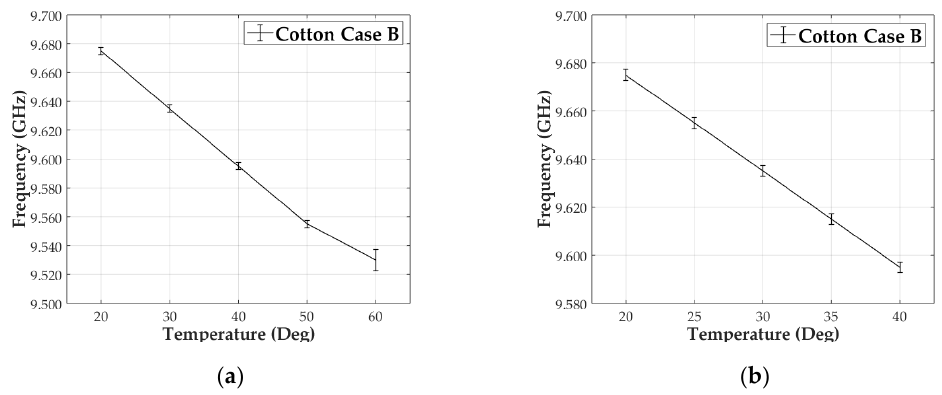
Figure 10. Measured frequency vs temperature representation. Cotton Case B at 9.45 GHz for: ( a ) 20– 60 °C/10 °C steps and ( b ) 20–40 °C/5 °C steps.